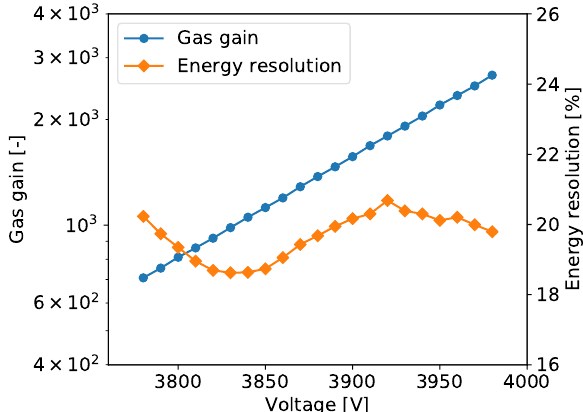
Figure 13. GEM detector C 2 . Gas gain and energy resolution vs. detector bias